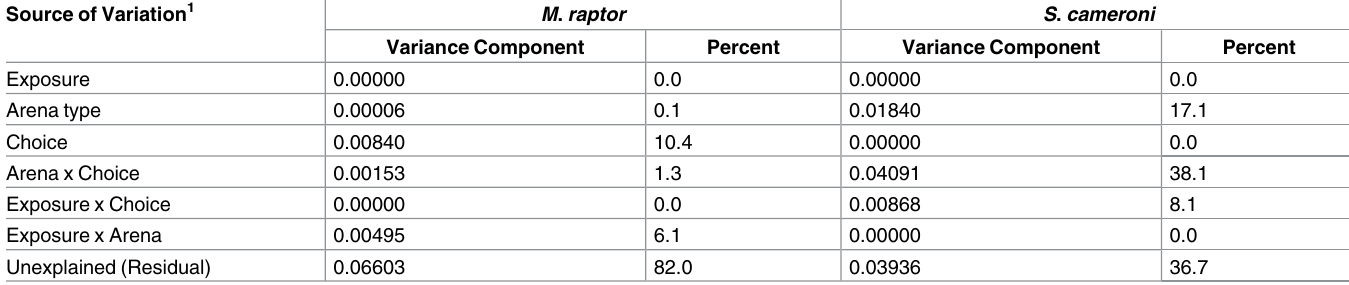
Table 1. Variance decomposition of the arcsine-square root transformed ratio of parasitoid progeny for one of the two choices (e.g. equine manure) offered to all parasitoid progeny in the arena for each tested parasitoid species, Muscidifurax raptor and Spalangia cameroni . Source of Variation 1 M .